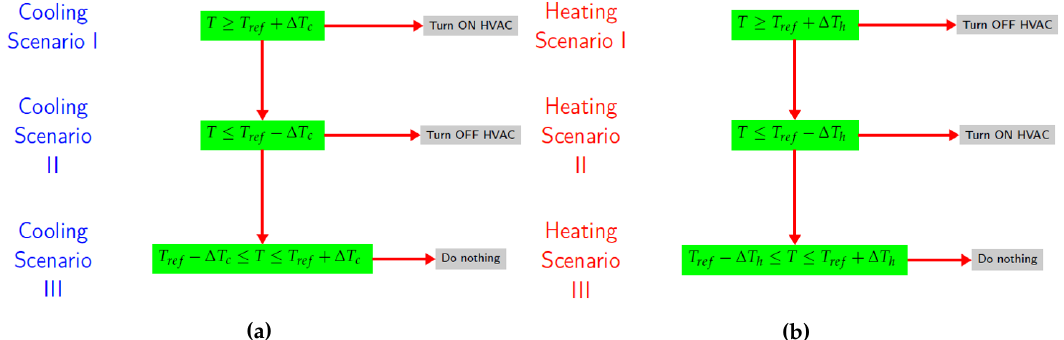
Figure 2. Overall scheme of baseline control (or RBC): ( a ) Overall scheme of baseline line control (or RBC) in summer cooling case; ( b ) Overall scheme of baseline line control (or RBC) in winter heating